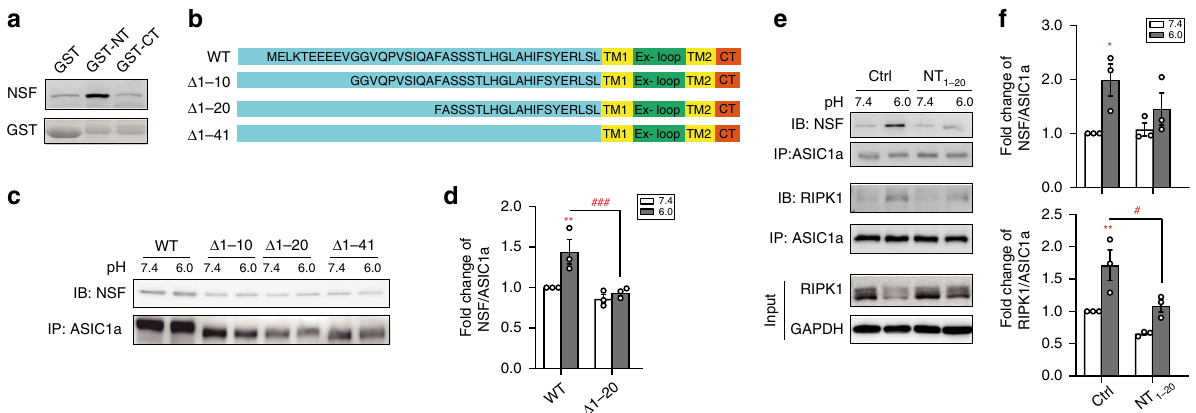
Fig. 4 NSF binds to the distal N-terminus of ASIC1a. a Glutathione-S-transferase (GST) pull-down assay showing the pulldown of NSF by GST-NT, but not GST-CT. Puri fi ed GST, GST-ASIC1a C-terminus (GST-CT) or GST-ASIC1a N-terminus (GST-NT) were incubated with mouse brain extracts, immobilized on glutathione-Sepharose 4B beads, and immunoblotted for NSF ( top ) and GST ( bottom ). GST alone served as a negative control. b Amino acid sequences of NT deletion mutants of ASIC1a. c Co-IP experiments showing that deletion of aa1-41 ( Δ 1-41) or aa1-20 ( Δ 1-20) decreased the acid-induced association between ASIC1a and NSF in CHO cells. d Summary data of ( c ). n = 3, ** p < 0.01 vs . corresponding pH 7.4, ### p < 0.001 vs . WT, by ANOVA. e Co-IP experiments showing that NT 1 – 20 (10 μ M, 0.5 h pretreatment) reduced acid-induced formation of NSF-ASIC1a-RIPK1 complex in cultured mouse cortical neurons. NT 1 – 20 also decreased acid-induced degradation of RIPK1 protein (lower panel). f Summary data of ( e ). n = 3, * p < 0.05, ** p < 0.01 vs . corresponding pH 7.4, # p < 0.05 vs . WT, by ANOVA. Error bars are SEM for all summary panels.